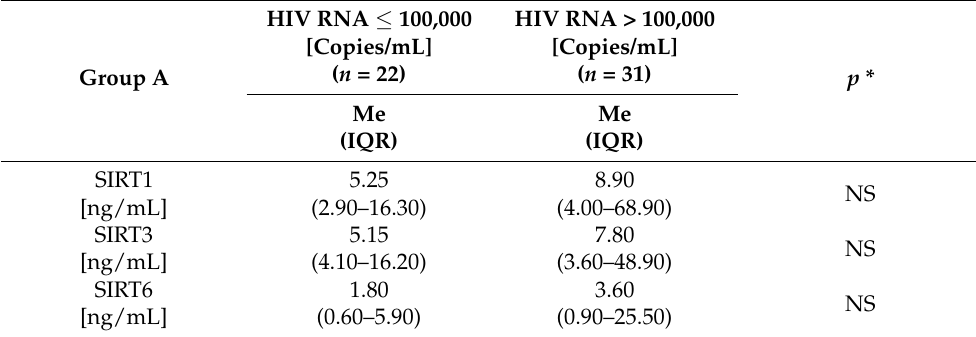
Table 6. Results for SIRT1, SIRT3 and SIRT6 in the plasma of HIV-infected men before cART ( A ) in the subgroup with HIV RNA ≤ 100,000 copies/mL, and in the subgroup with HIV RNA > 100,000